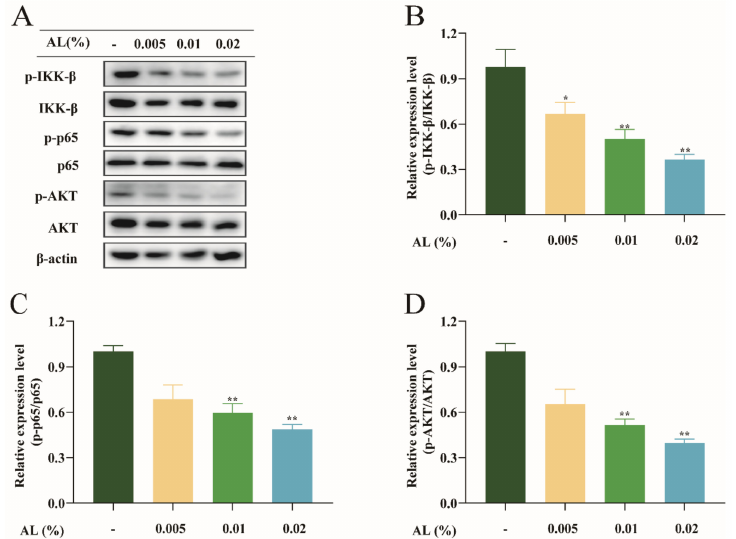
Figure 7. AL reduced H 2 O 2 -induced oxidative stress by inhibiting the NF- κ B signaling pathway in HaCaT cells. ( A ) Protein bands of IKK- β , p65, and AKT using Western blotting; ImageJ software protein quantification assay of IKK- β ( B ), p65 ( C ), and AKT ( D ). Results are expressed as means ± SDs of three independent experiments. ** p < 0.01, * p < 0.05 compared to the normal group (no treatment). Significance was measured using a one-way ANOVA.